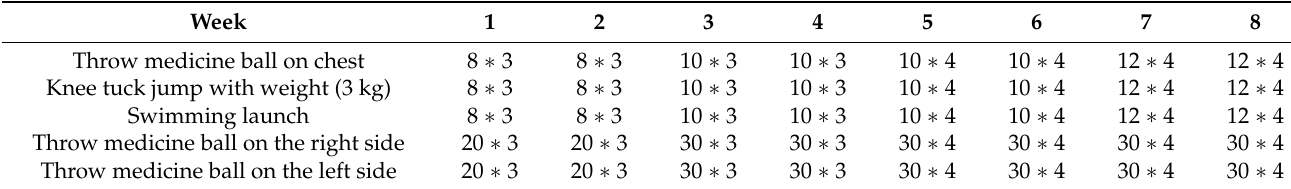
Table 2. BT program. Data are presented as repetitions ×